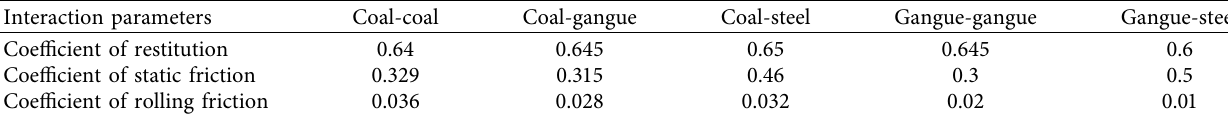
Table 2: Material interaction